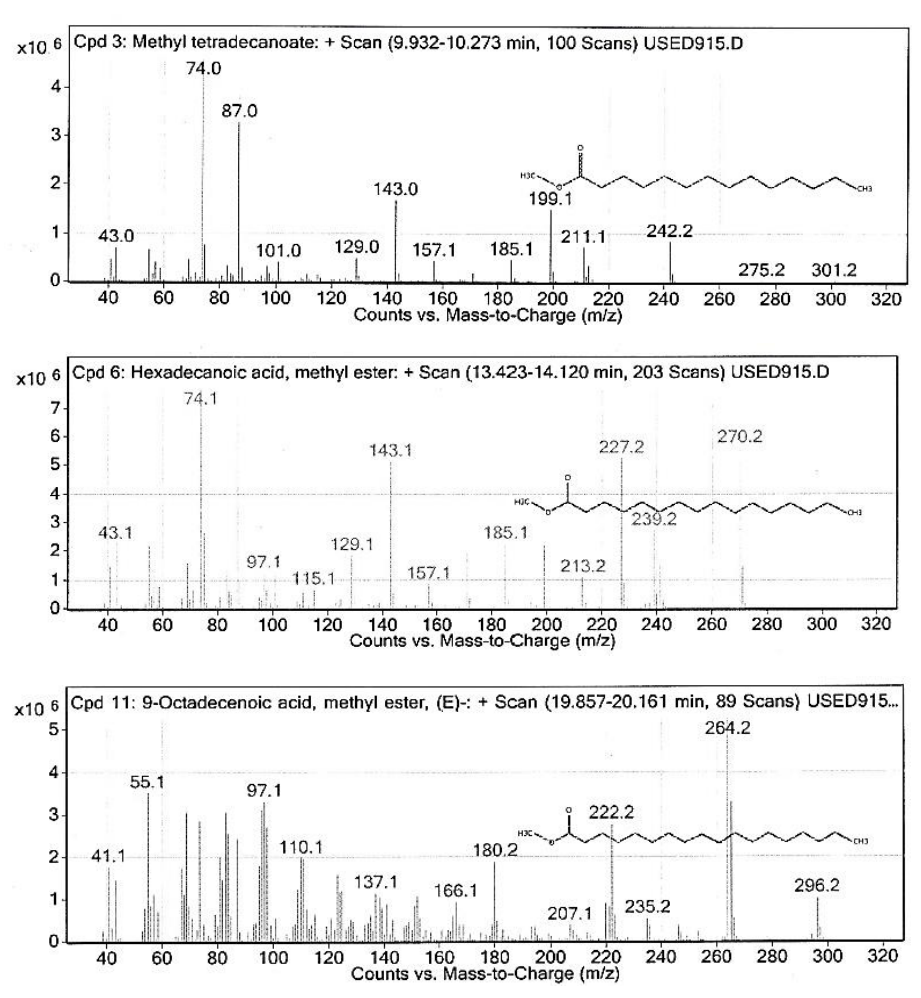
Figure 10: Mass spectrum of selected components after transesterification using calcined